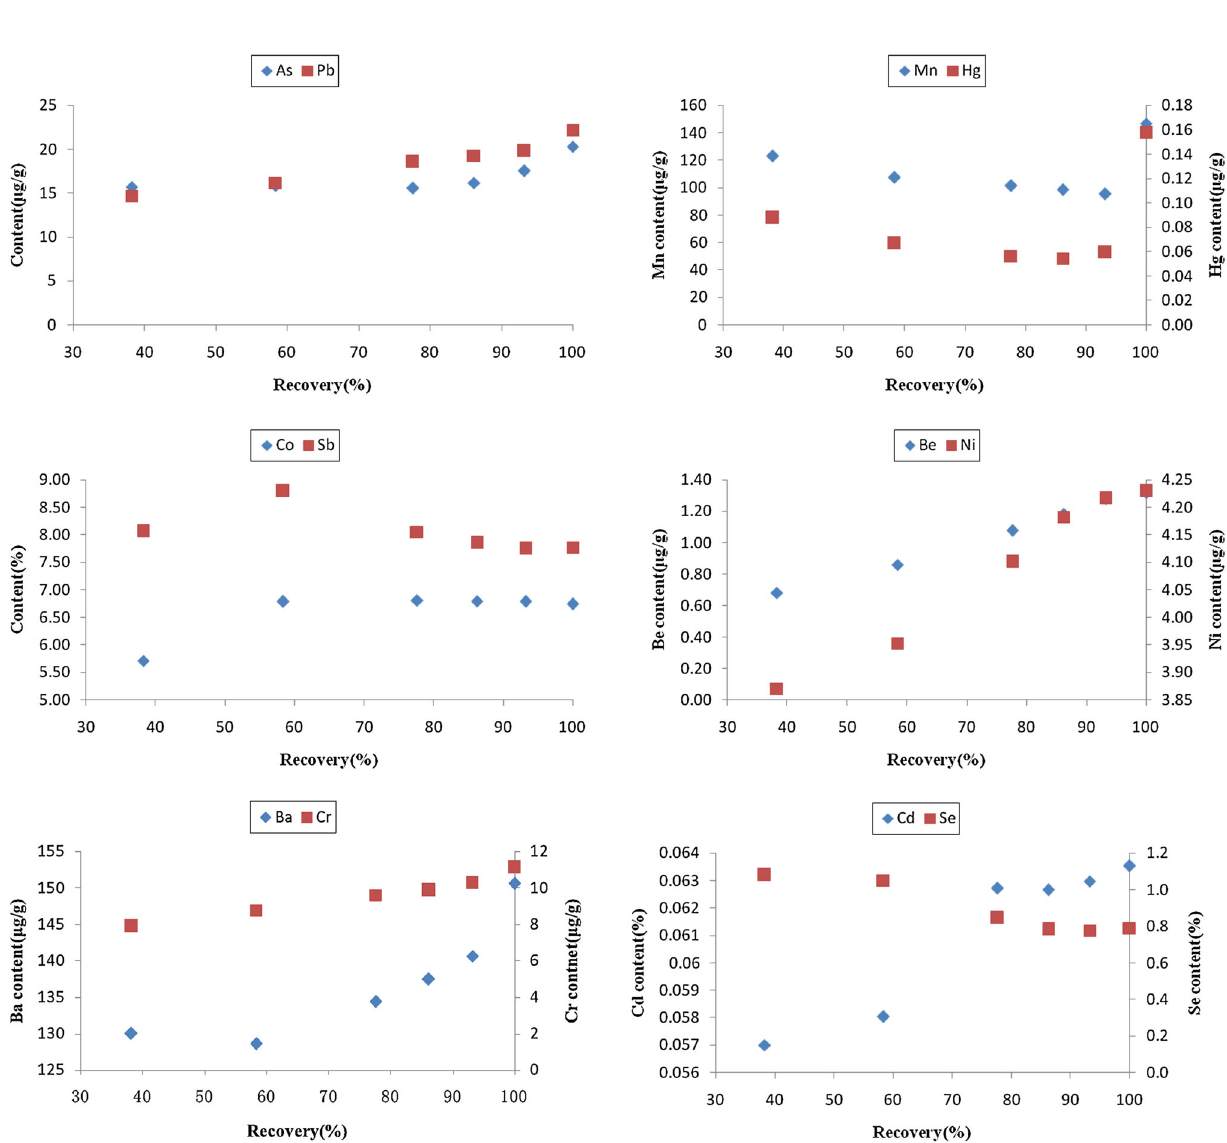
Fig. 8 Washability curves for trace elements in the No.14 coal from the Huolinhe